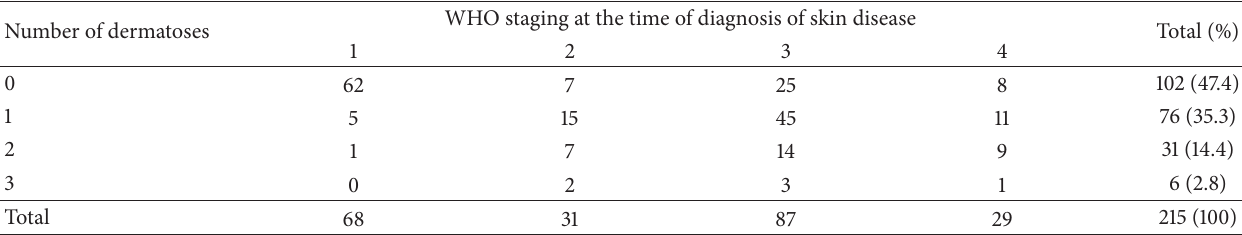
Table 3: Number of dermatoses in relation to WHO clinical